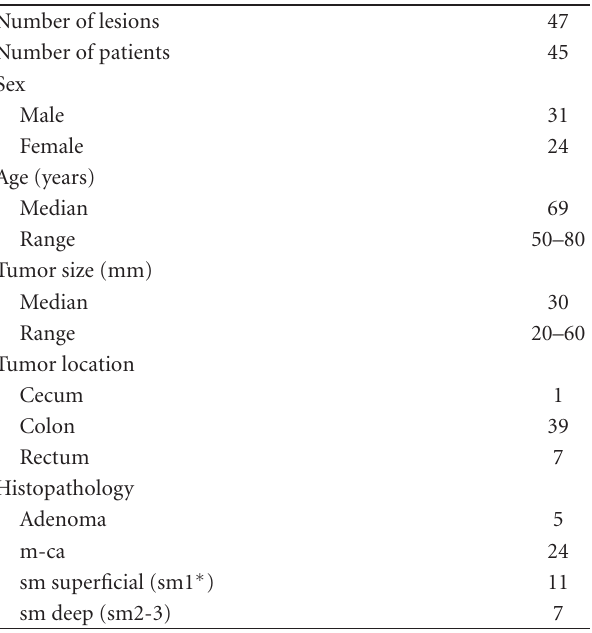
Table 1: Characteristics of lesions.